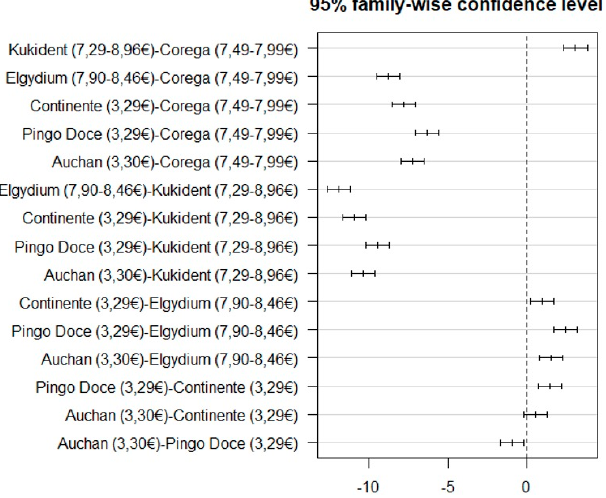
Table 3. Comparisons of adhesive retention by fixation and brand. Figure 6. Tukey multiple comparison tests for adhesive retention capacity between all brands.